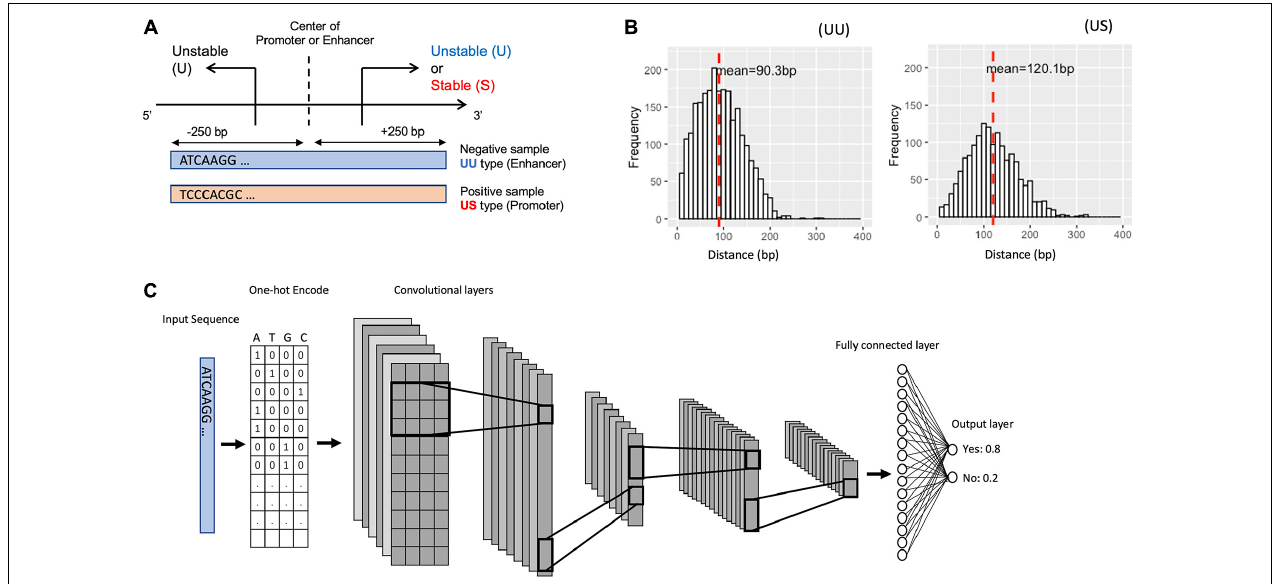
FIGURE 1 | Schematic representation for bidirectional TSSs addressed in this study and for the structure of the proposed deep learning model. (A) The definition of the promoter and enhancer TSS pairs. (B) Histogram showing the distance distribution between the sense and the antisense TSSs. (C) The overall structure of our CNN model. TSS, transcriptional start site; CNN, convolutional neural network.